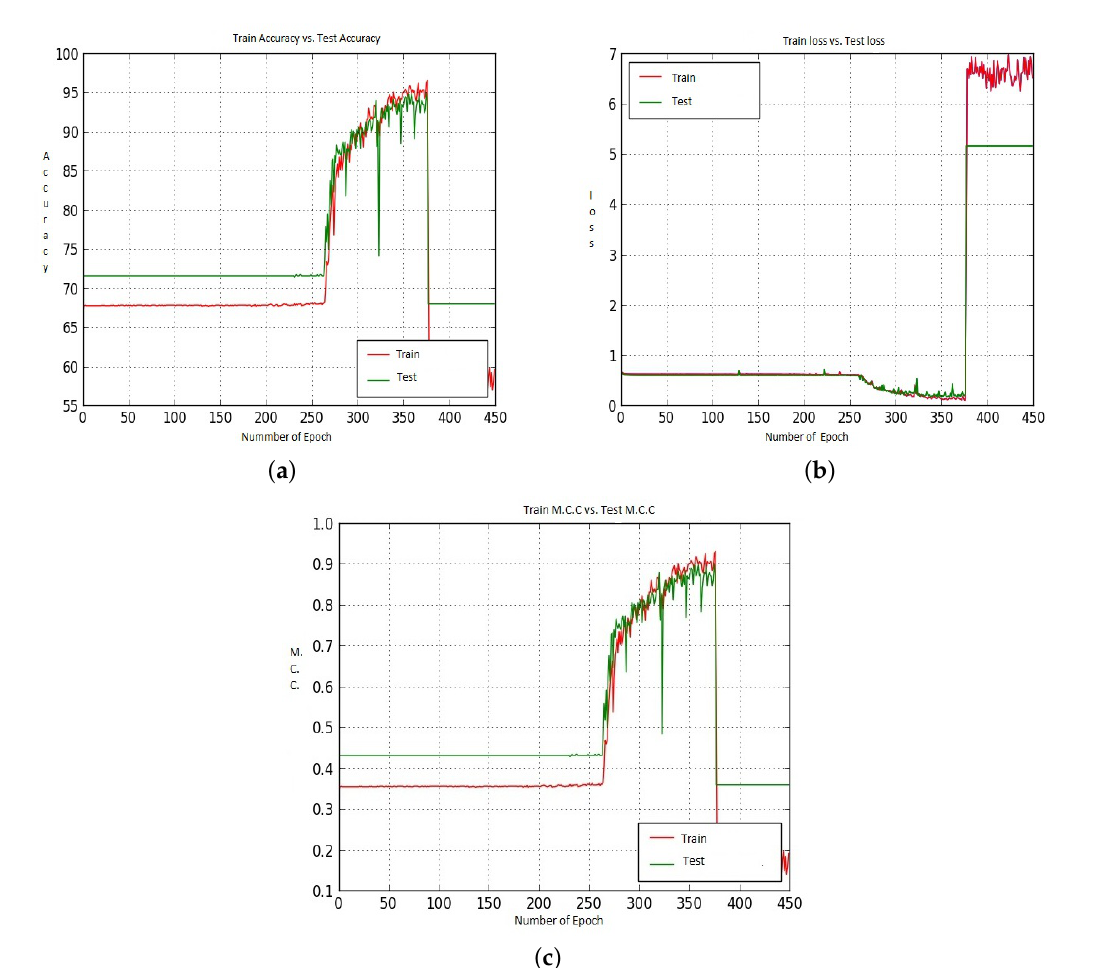
Figure 13. ( a – c ) represent the Train and Test Accuracy, Loss and M.C.C. values when we have utilized Model-2, CNN-CH on the 100 × dataset.